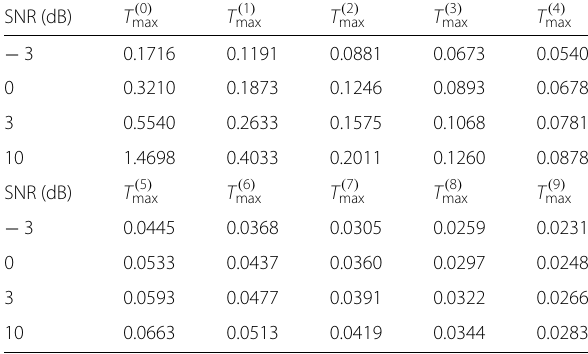
Table 2 Maximum EST of round-robin scheme for different